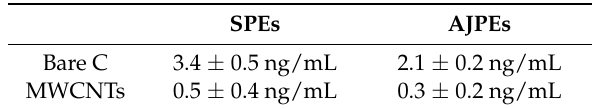
Table 4. LOD obtained from the different conditions, considering different WE materials and printing methods.